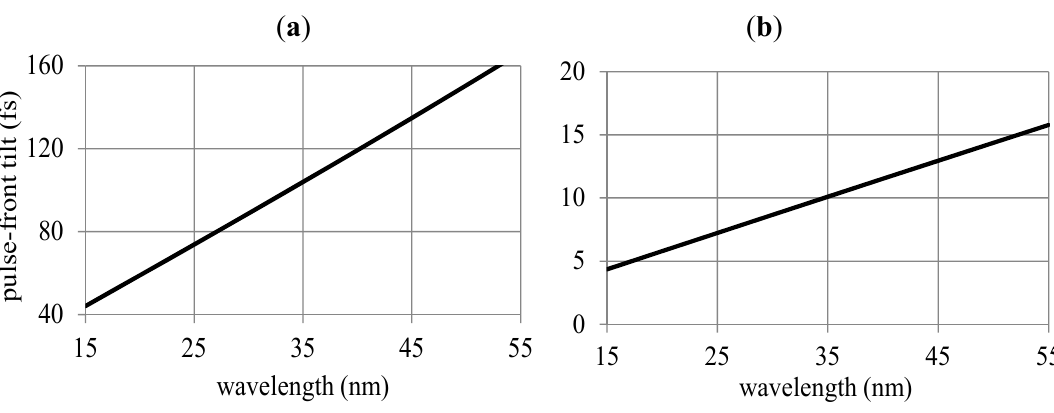
Figure 3 . Pulse-front tilt of the monochromator with the parameters listed in Table